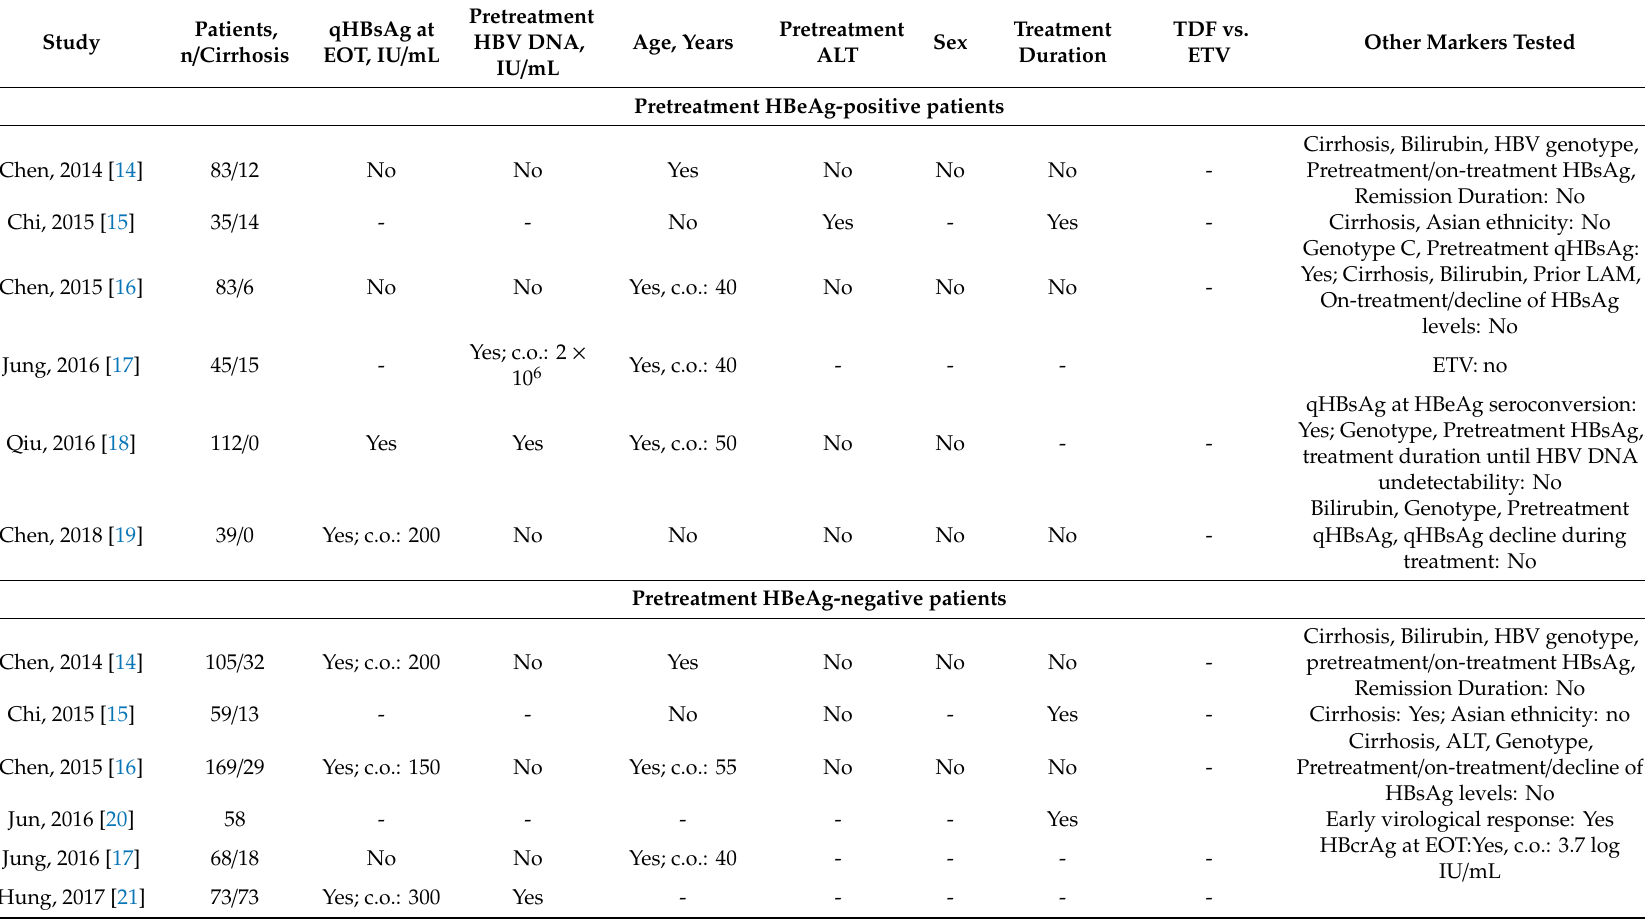
Table 1. Predictors of virological relapse after discontinuation of nucleos(t)ides analogues (NAs) in studies including chronic hepatitis B (CHB) patients who remained HBsAg positive at the end of therapy (EOT). Predictors are provided separately for pretreatment HBeAg-positive patients who achieved HBeAg seroconversion and pretreatment HBeAg-negative patients, when available, or mixed patients when separate analyses were not